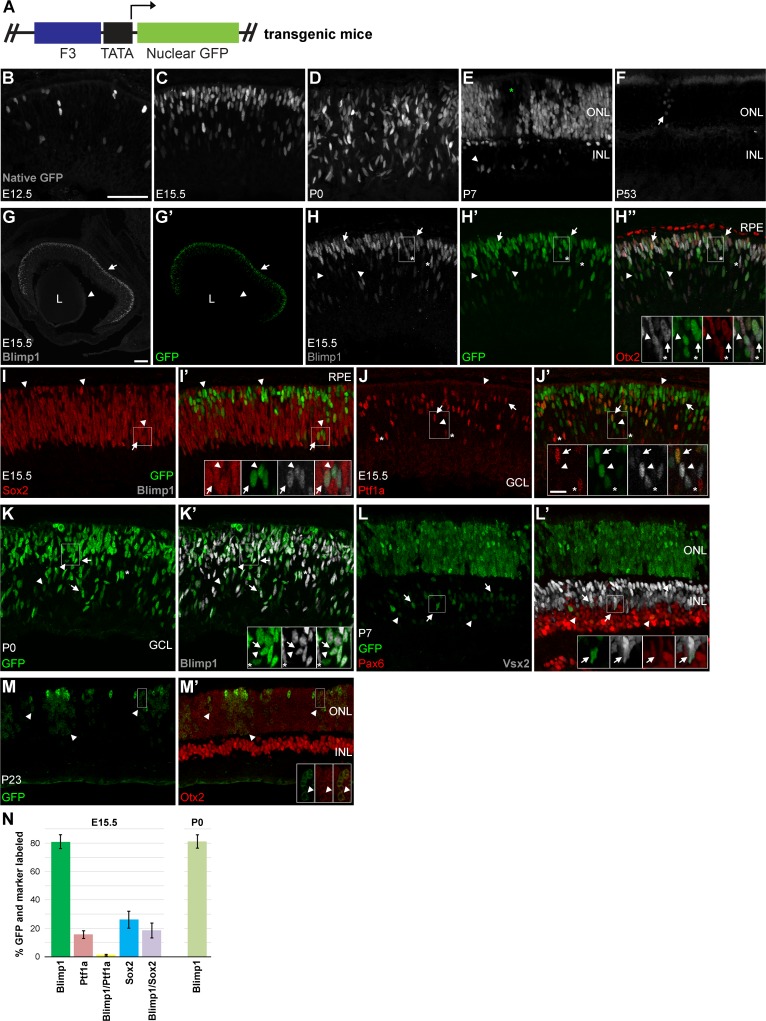
F3-nGFP transgenic mice recapitulate Blimp1 retinal expression in vivo.(A) Schematic of the construct used to generate transgenic mice. (B-F) Native GFP fluorescence (grey) at multiple developmental stages. GFP is first seen in the retina at E12.5 (B), similar to Blimp1 expression. The number of cells expressing GFP at E15.5 (C) and P0 (D) progressively increases. GFP is still expressed at P7 (E), when Blimp1 protein is becoming downregulated. Signal is mostly in the ONL, but some cells in the inner nuclear layer (INL) are evident (arrowheads). Some transgene mosaicism is seen (green asterisk). At P53, weakly GFP+ cells are occasionally seen in the ONL (arrow). (G-J’) E15.5 F3-nGFP transgenic mice stained for cell type-specific markers (red, grey). (G-G’) Low-power view of the eye. The GFP signal (green) closely matches the Blimp1 immunostaining pattern (grey, arrows). No GFP is seen in the lens (L) or surrounding tissues. Arrowheads mark Blimp1+ vascular endothelial cells in the hyaloid vasculature. These do not co-express GFP, demonstrating retinal specificity of the transgene. (H-H”) High-power view of sections co-stained for Blimp1 (grey) and Otx2 (red). Most GFP+ cells co-express Blimp1 and Otx2 (arrows, insets). About 20% of GFP+ cells do not co-express Blimp1 (arrowheads, insets). A small number of Blimp1+/Otx2+ cells do not express GFP (asterisks, insets). The Otx2+ retinal pigmented epithelium (RPE) does not express GFP or Blimp1. (I-I’) Sections co-stained for Blimp1 (grey) and the progenitor marker Sox2 (red). Most GFP+ cells do not express Sox2 (arrowheads, insets). About 25% of GFP+ cells co-express Sox2, but most of these also co-express Blimp1 (arrows, insets). Thus, few progenitors (Sox2+/Blimp1-) express GFP. (J-J’) Roughly one in six GFP+ cells co-express the amacrine and horizontal cell precursor marker Ptf1a (red, arrows, insets). Unlike Sox2, few of these GFP+/Ptf1a+ cells co-express Blimp1 (grey). Arrowheads (insets) mark GFP+/Blimp1+ cells that do not co-express Ptf1a while asterisks (insets) mark Ptf1a+/GFP- cells. (K-K’) At P0, the majority of GFP+ cells co-express Blimp1 (arrows, insets). About 20% of GFP+ cells lack Blimp1 co-expression (arrowheads). Asterisks mark the uncommon Blimp1+ cells that do not co-express GFP. No GFP is seen in the RPE. (L-L’) GFP expression is widespread at P7 and predominately labels photoreceptors in the ONL. Weaker INL staining overlaps with either Pax6+ amacrines (red, arrowheads, insets) or Vsx2+ bipolars (grey, arrows, insets). No staining of the RPE or vascular endothelial cells is seen. (M-M’) Blimp1 is no longer expressed at P23, but GFP+ cells are still detectable by immunostaining. GFP expression levels are modest and the signal overlaps with Otx2 (red) in the ONL (arrowheads, insets). Mosaic GFP expression is more common and pronounced in older retinas. Scale bars are 50 μm for panels B-F, H-M’, 10 μm for insets, and 100 μm for G, G’. (N) Plot showing the average percentage of GFP+ cells that co-express cell type-specific markers at E15.5 and P0. Error bars represent the S.D.